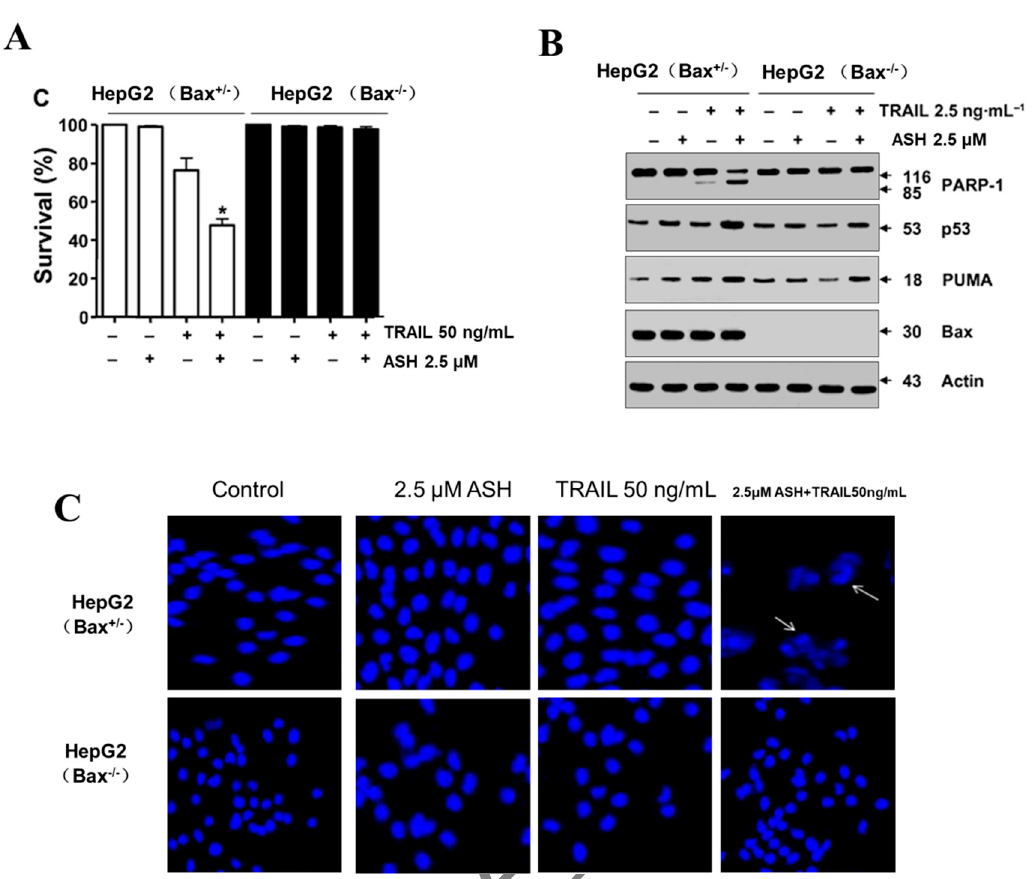
Figure 8. Bax contributed to apoptosis induced by ASH and TRAIL. ( A , B ) 2.5 μ M ASH and 50 ng/mL TRAIL were exposed to HepG2 Bax+/ − and HepG2 Bax − / − for 8 h. Control group received an equal amount of vehicle (PBS + 0.01% BSA+0.1% DMSO). Cells’ survivals were detected by the Trypan blue dye exclusion assay. The cleavage of PARP-1 and the expression of PUMA, p53 and Bax were analyzed by the Western blotting assay * p < 0.05. ( C ) The DAPI staining test was performed to assess apoptosis-inducing e ff ects of ASH and TRAIL combination therapy in HepG2 Bax+/ − and HepG2 Bax − / − cells. Chromatin condensation of the tumor cells was shown with white arrows observed by fluorescence microscopy (Magnification× 200).